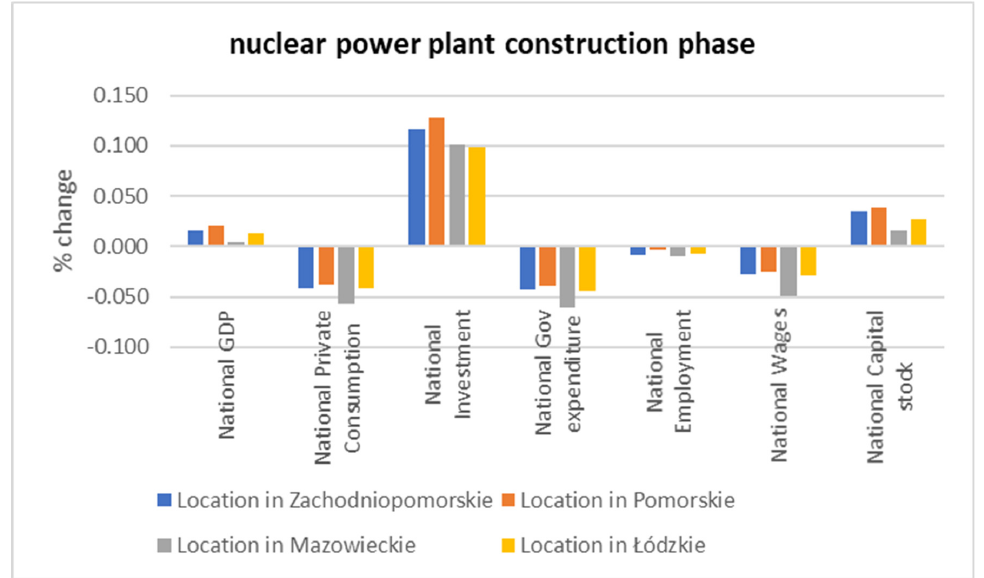
Figure 4. National impact of nuclear plant location in each of the four regions, considering the construction phase in cumulated years 2025–2040.